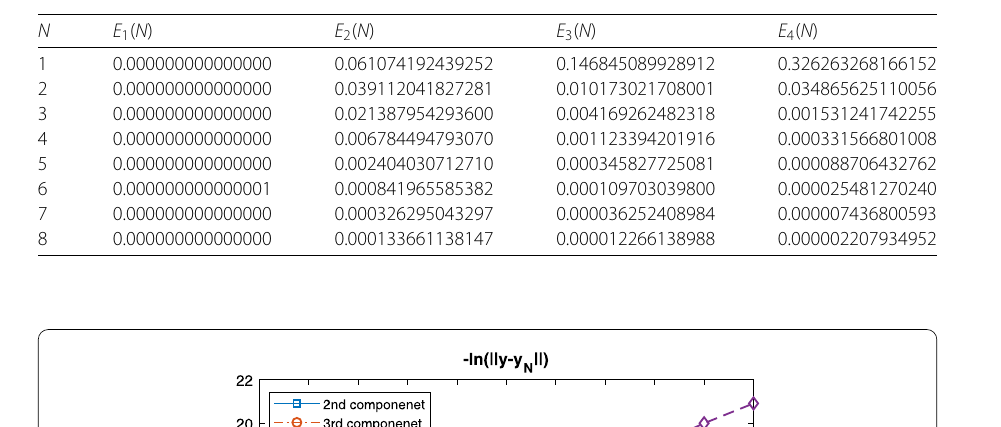
Table 3 The max error for Example 8.2 for α = 0.9